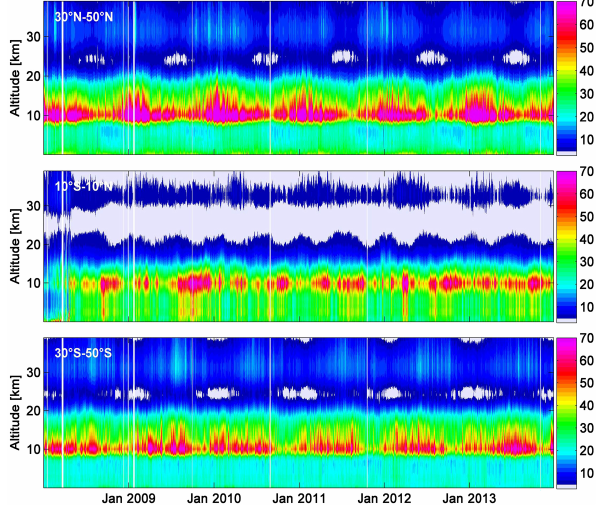
Figure 5. Daily IASI O 3 variability (%), expressed as (cid:2) σ ( O (cid:3) × 100%, where σ is the standard devia- 3 (t))/ O 3 (t) tion, as a function of time and altitude in three latitude bands: 30–50 ◦ N (top), 10 ◦ S–10 ◦ N (middle) and 30–50 ◦ S (bottom).